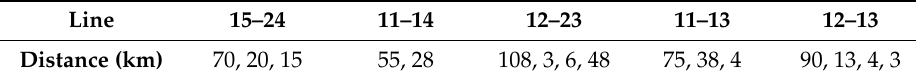
Table 11. The locations of fault points.